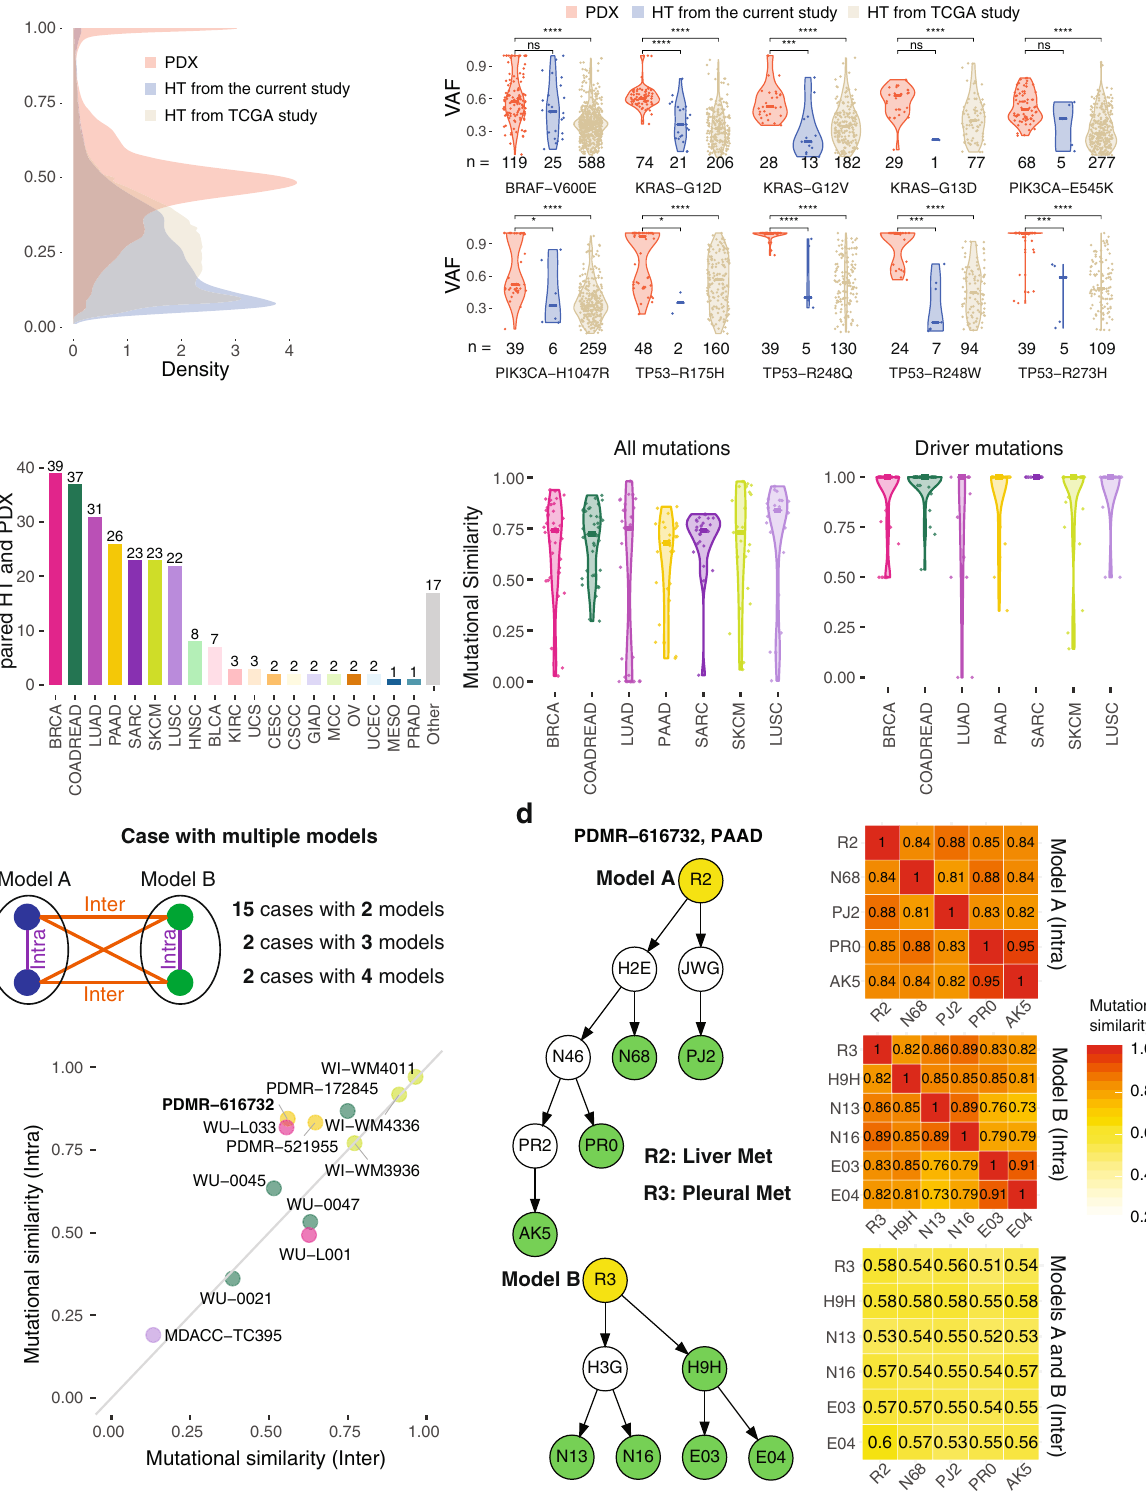
Fig. 2 The landscape of somatic mutations in human tumors and PDXs. a Comparison of variant allele frequency (VAFs) for mutations between PDX and TCGA data. Number of samples (n) for each group is shown in the fi gure. b Number of patients with both human and PDX samples and the similarity of somatic mutations between them across different cancer types. c Mutational similarity among samples from different PDX models. d Schematics of tree plots of two PDX models from example case PDMR-616732 and the heatmap matrix of intra- and inter-mutational similarity. The mutational similarity quanti fi es the percentage of overlapping mutations between two samples. In a., we use two-sided Wilcoxon rank-sum test for calculating p values, where *, **, ***, and **** stand for p -value < 0.05,< 0.01, < 0.001, and < 0.0001 respectively. Source data are provided as a Source Data fi